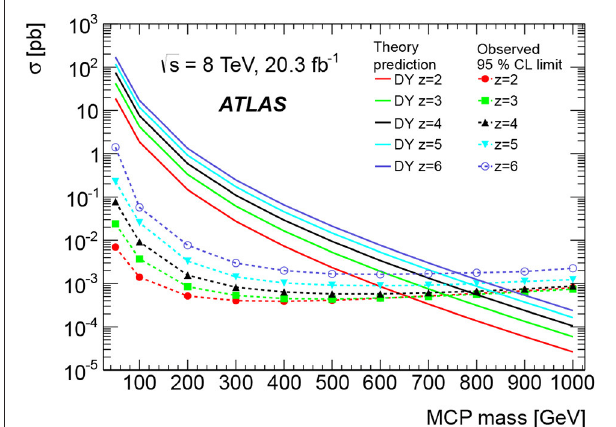
FIGURE 4 | Observed 95 % CL cross-section upper limits and theoretical cross-sections as functions of the multi-charged particles mass. Again, the double charged particles are denoted as “ z 2” (red points and lines). = The picture is taken with the according permission from Bulekov et al.